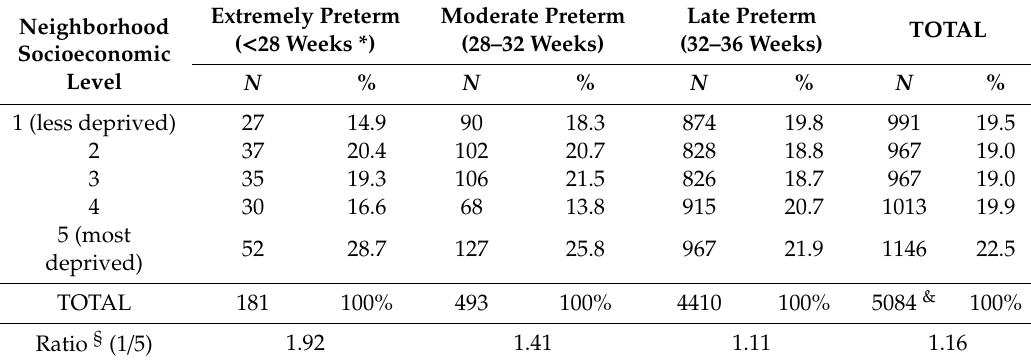
Table 4. Preterm birth distribution by specific gestational age and by neighborhood socioeconomic level: